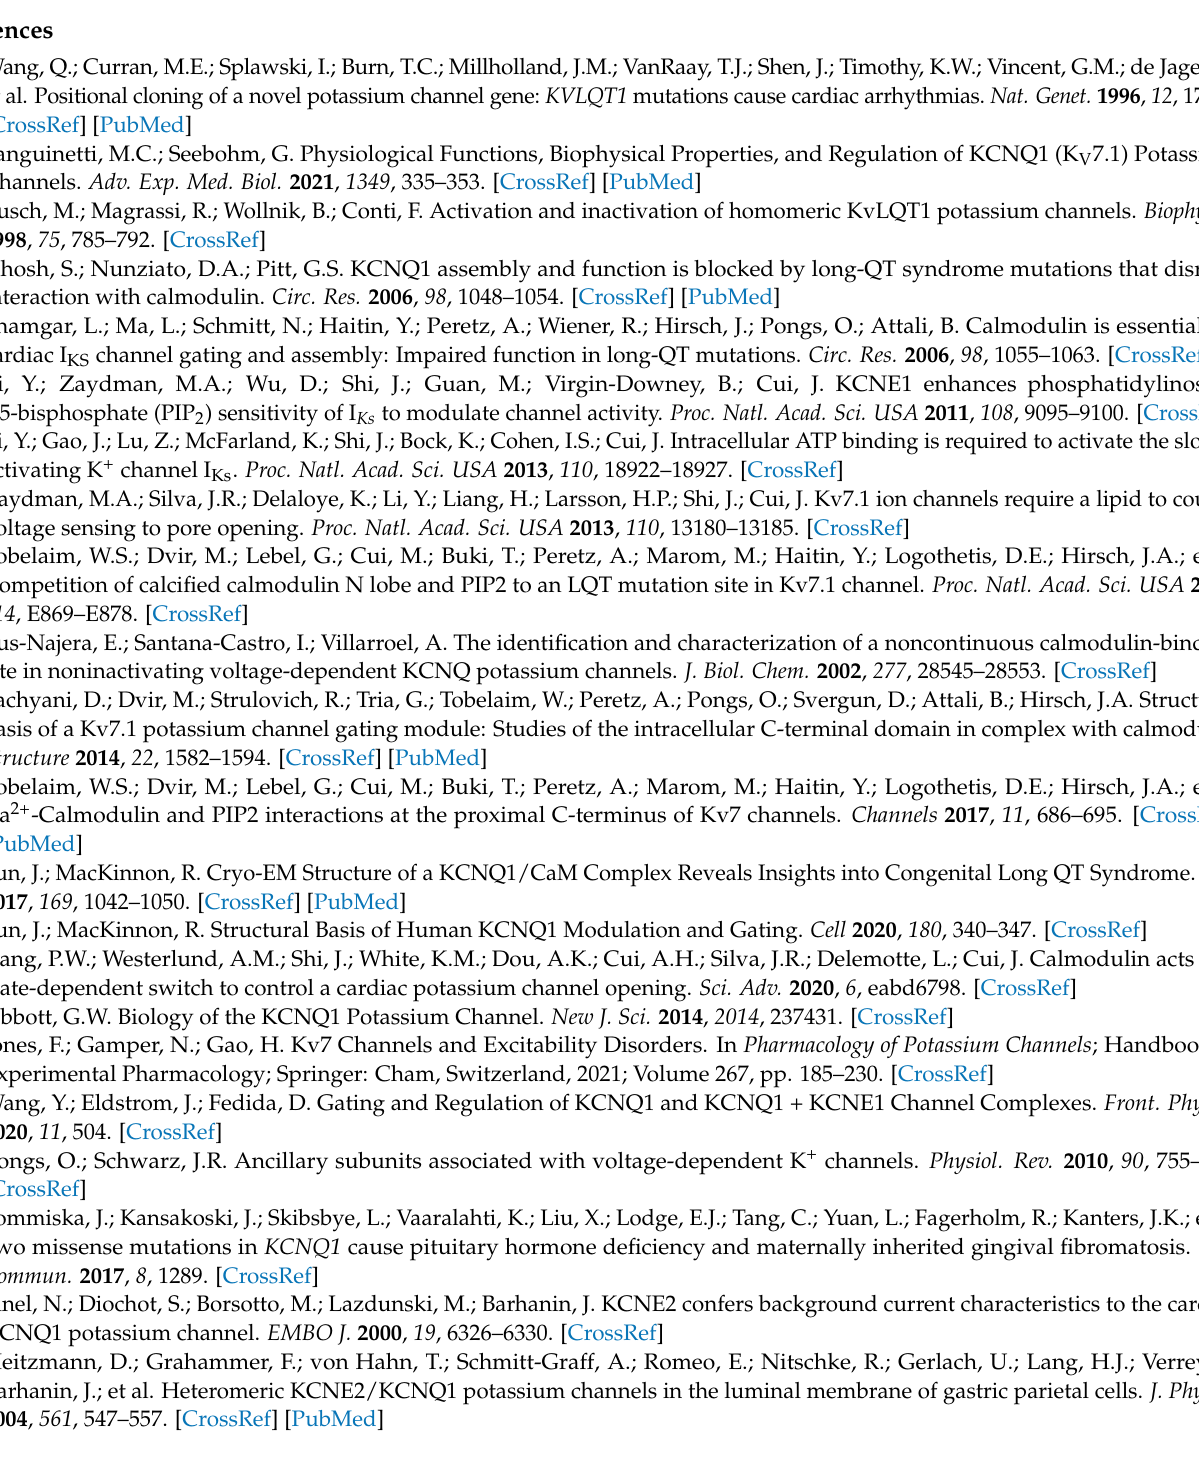
R116, V185 and P369, as well as the close proximity of R116 and V185 to the CaM C-lobe in the PIP2-free state ( A ), but not in the PIP2-bound ( B ) state. ( C ) Structure model of one KCNQ1, CaM and KCNE3 (green) subunit of the tetrameric KCNQ1-KCNE3-CaM complex in the PIP2-bound state and orientation in the membrane (based on pdb 6V01). PIP2 is shown as balls and sticks. The inset on the right shows a magnified reoriented view of the PIP2 binding pocket. R116 and V185 are highlighted in magenta. Side chains of residues in the vicinity of PIP2 are shown as